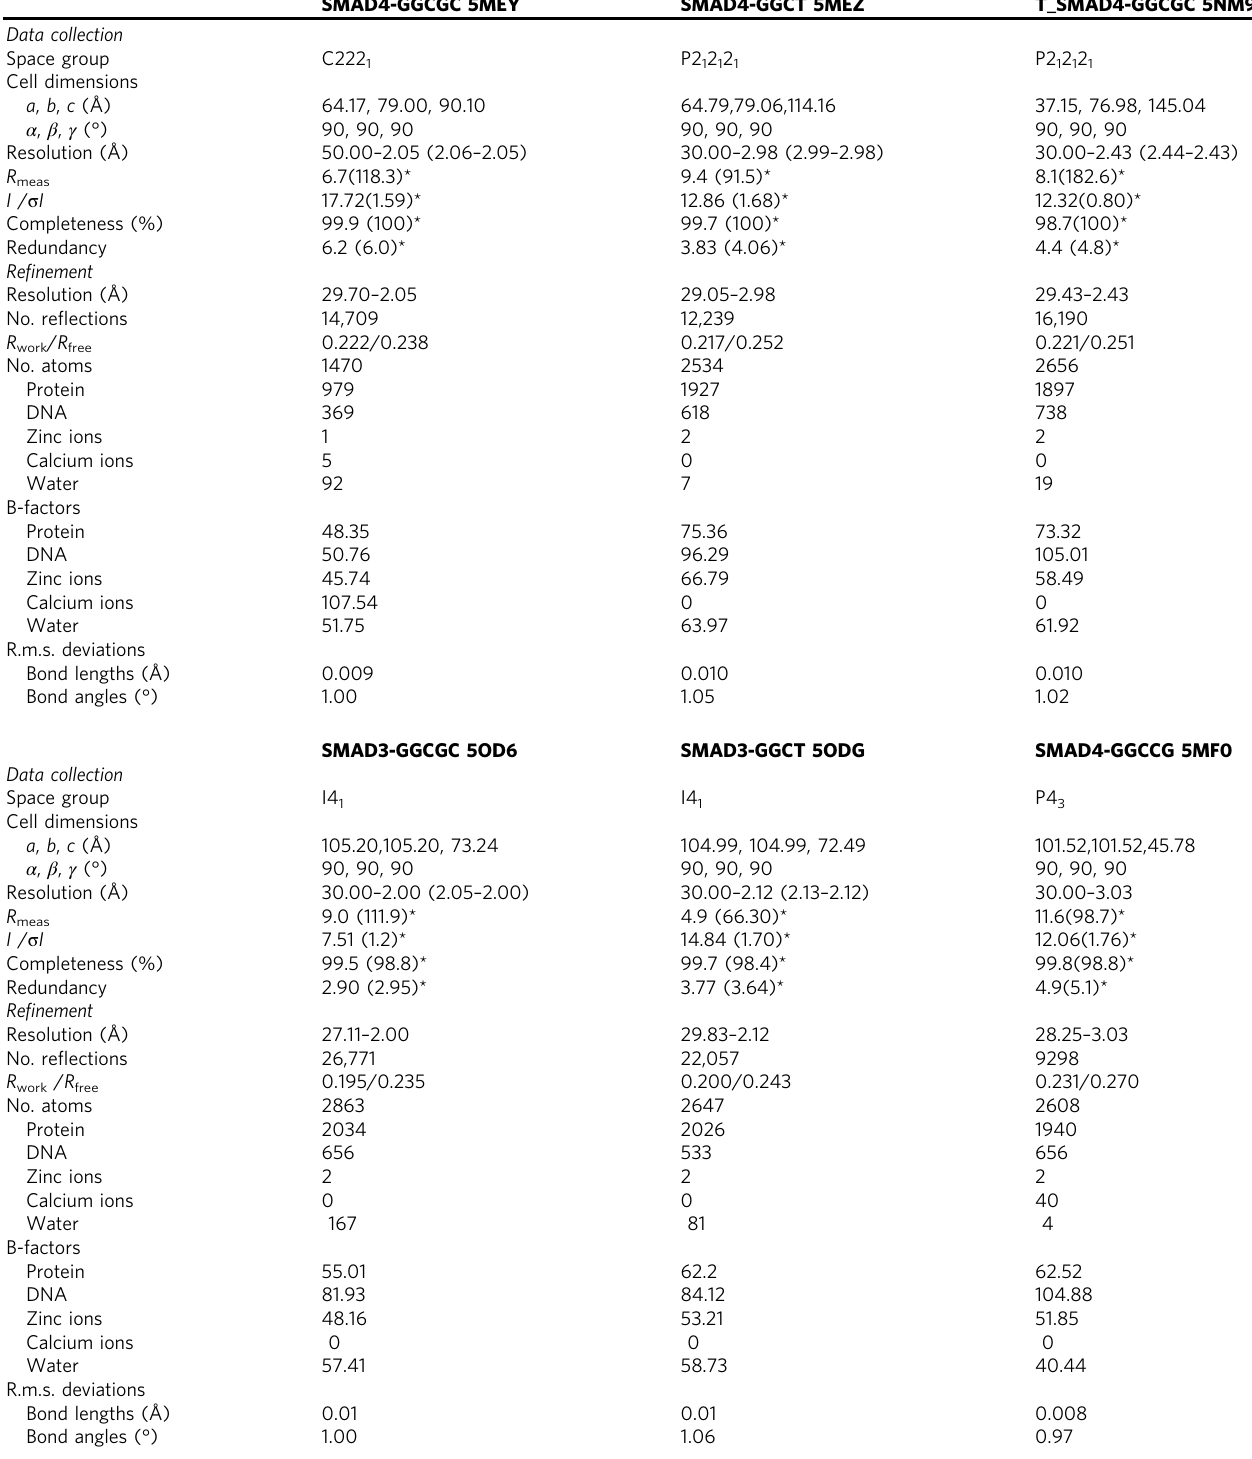
Table 1 X-ray data collection and re fi nement